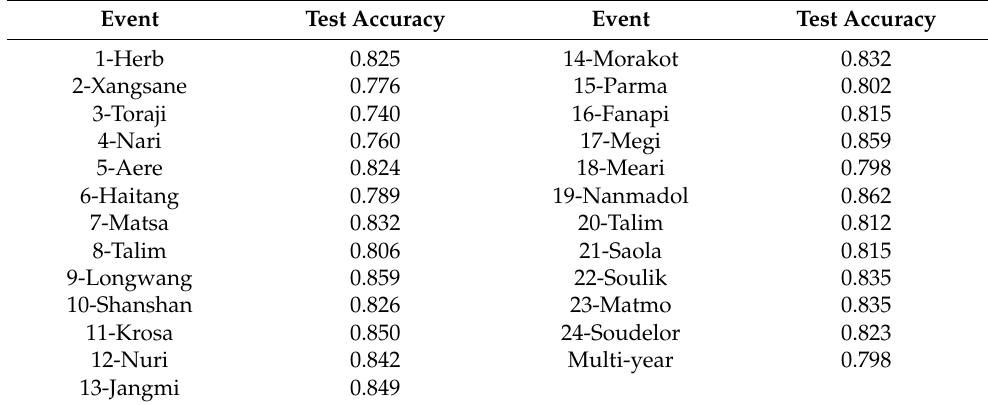
Table 4. Performances of the LR models.